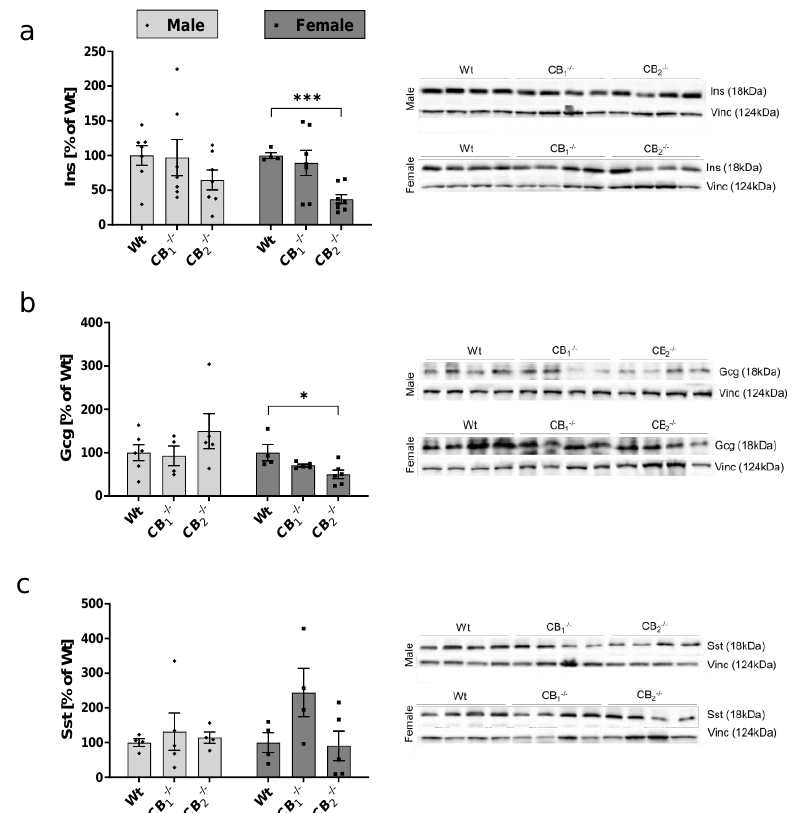
(± S.E.M.) with n = 4 – 12 mice per group defining Wt values as 100%. * p < 0.05; *** p < 0.001 for comparisons between male or female Wt and knockout mice; unpaired t -test.